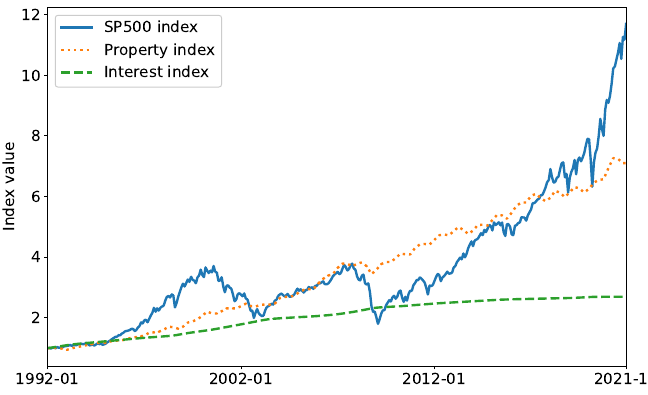
Figure 1. Three asset value indices for a period of 30 years: The S&P 500 stock index, the Norwegian property index, and the Norwegian interest rate index. All indices are relative to their respective values on 1 January 1992. While the stock index performs the best overall, it has the highest volatility and therefore the highest risk. Conversely, the interest rate index has the lowest risk but also the lowest growth.